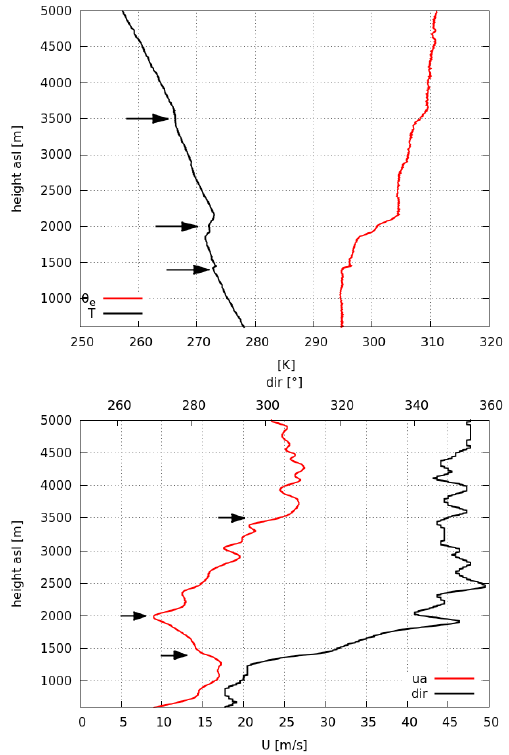
Figure 5. Munich radiosonde data on 5 January 2013, 12:00UTC: temperature T and the equivalent potential temperature (cid:50) e (upper panel) and wind speed and direction (lower panel).